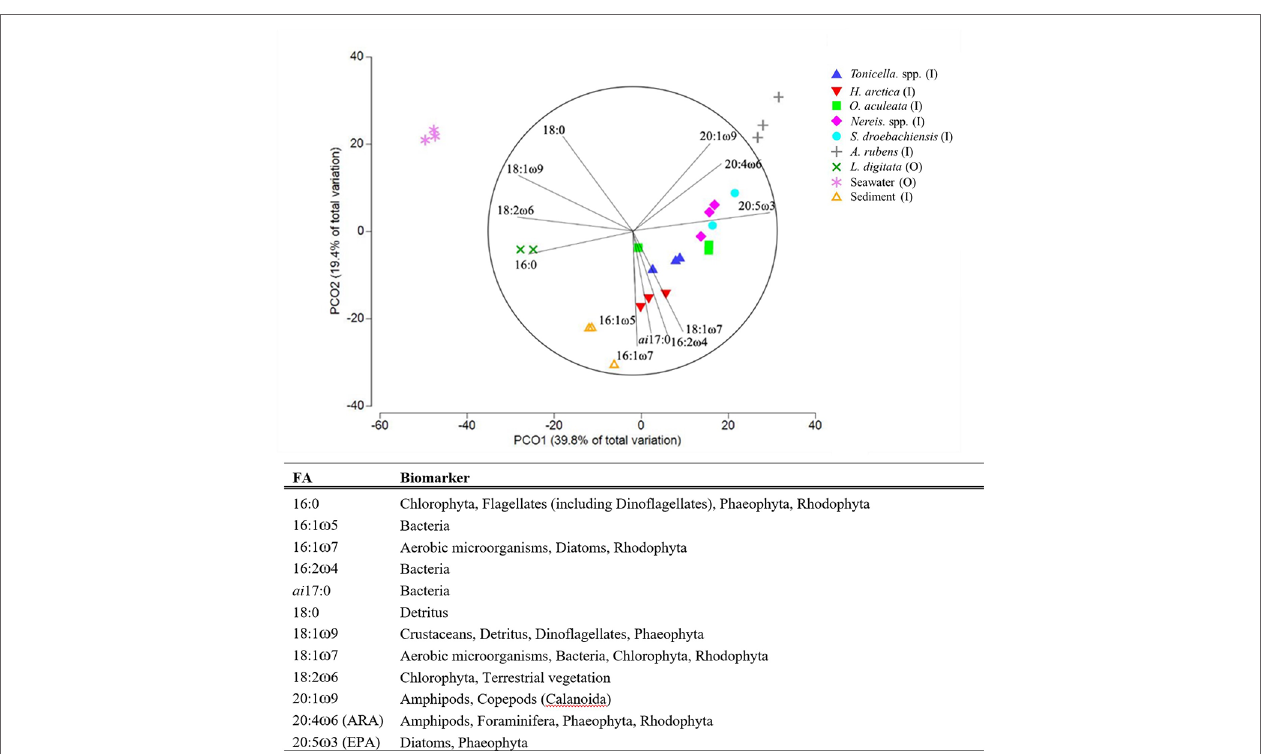
FIGURE 4 | (A) PCO plot (based on Bray-Curtis similarity matrices) of the 12 fatty acids exhibiting at least 70% correlation in the six animal species, two macroalgal species, and two environmental components (see Table 1 for species list) sampled inside or outside of the South site (see Figure 1A ). (B) Typical fatty-acid trophic biomarkers for those fatty acids included in the analysis (adapted from Parrish (2013) and Lege ż y ń ska et al. (2014).